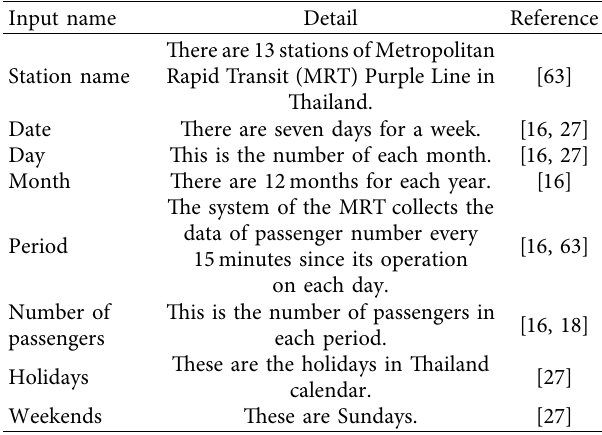
Table 1: Input data.